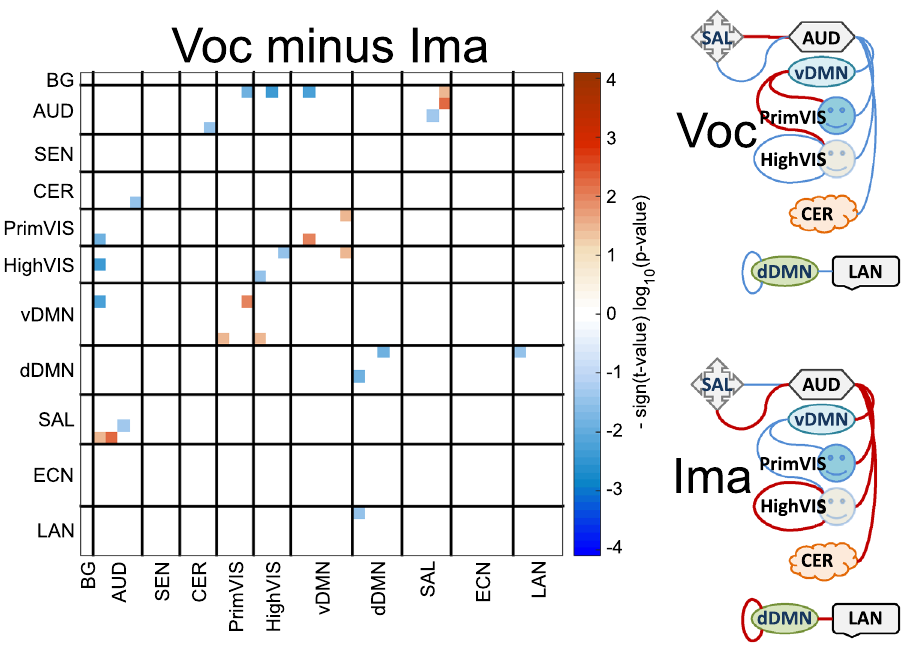
Figure 6. Significant results for the “vocalize minus imagine” contrast. Non-significant results are displayed in white. On the right side panel, red thick lines indicate stronger connectivity and blue thinner lines indicate